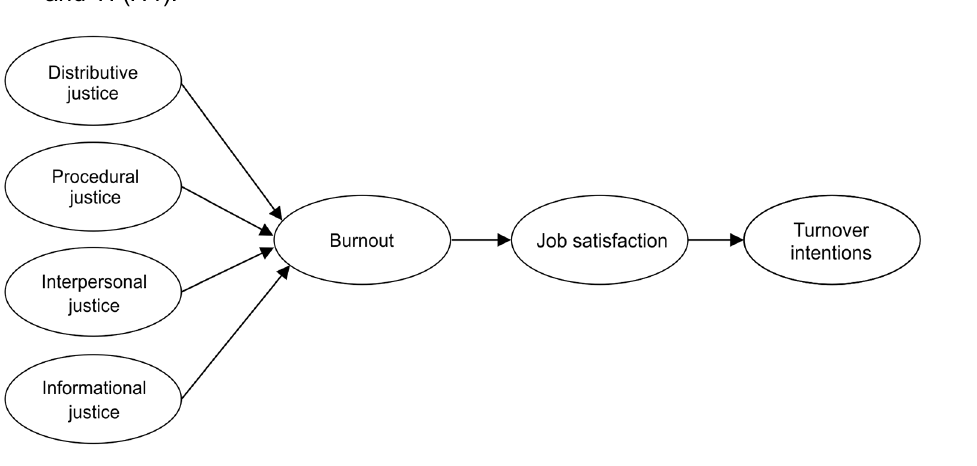
Figure 1. Proposed serial mediation